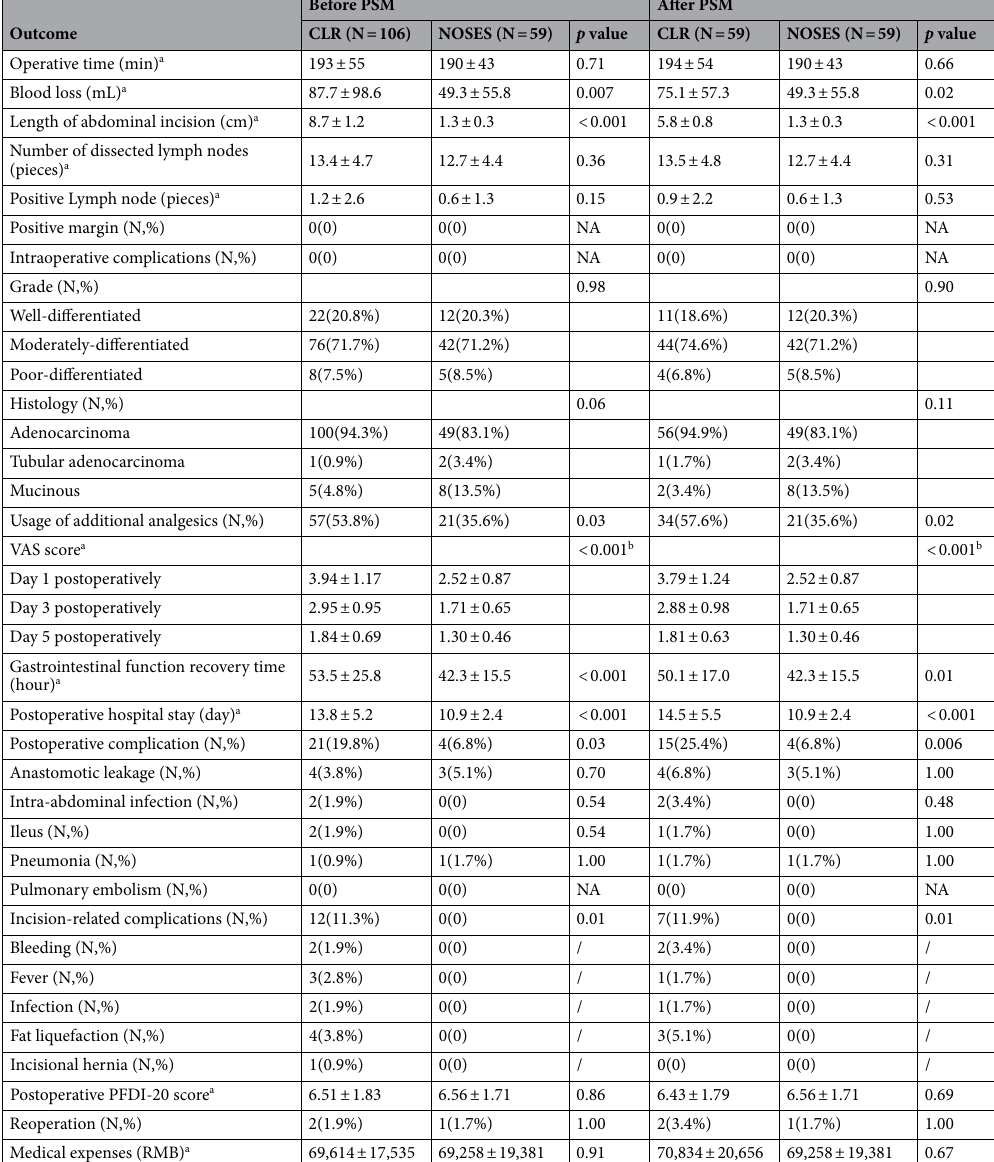
Table 2. Comparison of postoperative conditions between the two groups. a Mean ± SD. b The p value was calculated by a two-way repeated measures ANOVA.